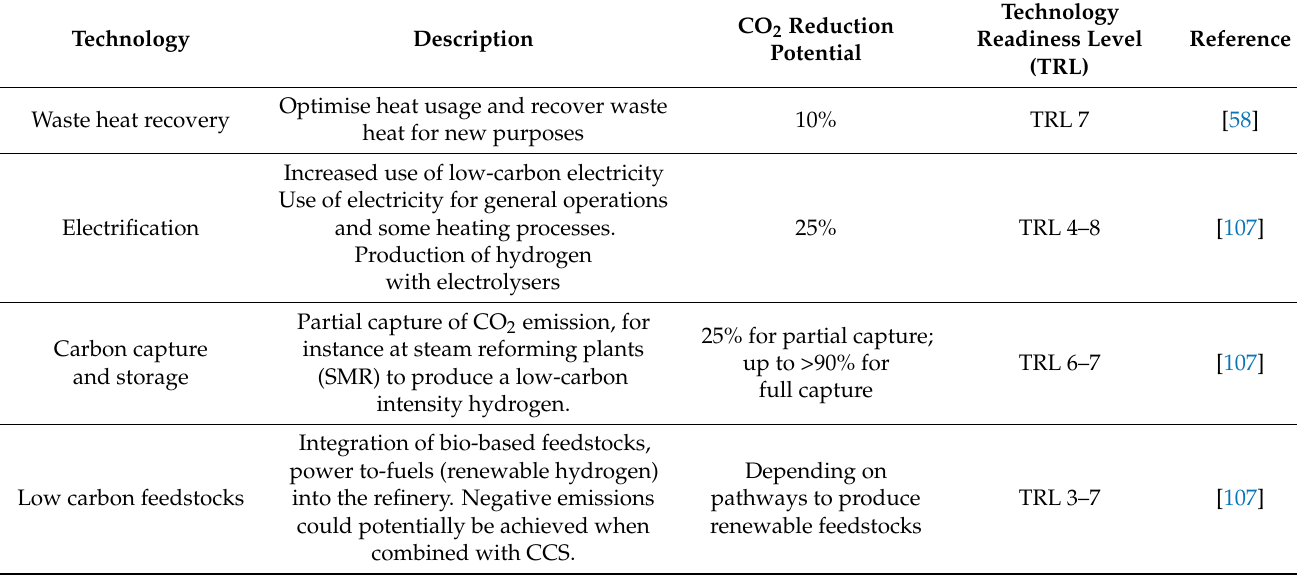
Table 3. Technical options for decarbonisation of refinery industry including CO 2 reduction potential and technology readiness levels (TRLs). See [49] for a description of the